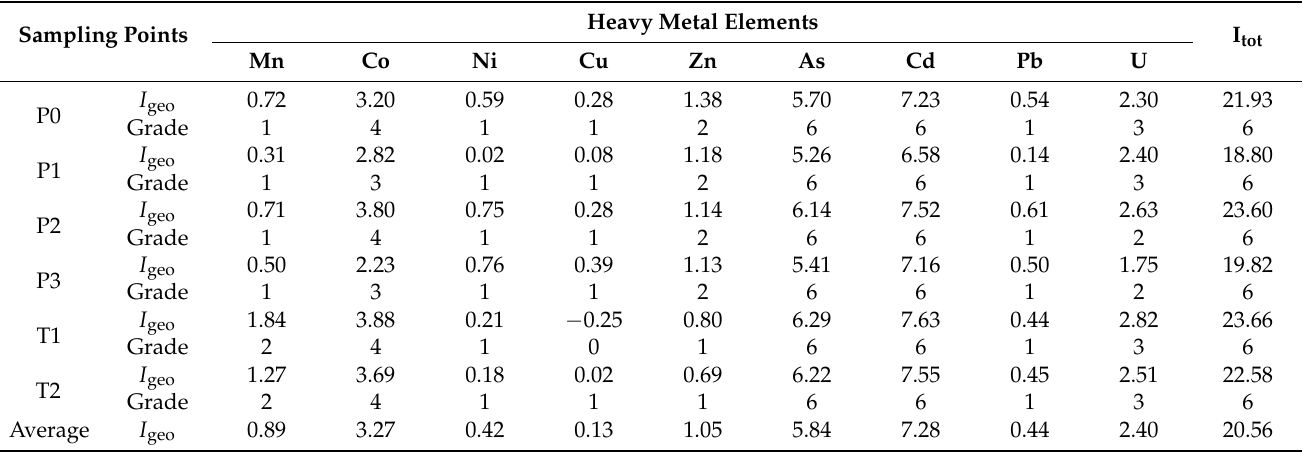
Table 7. Igeo values of the soil uranium and heavy metal accumulation index and evaluation results of the pollution level in a uranium mining area in northern